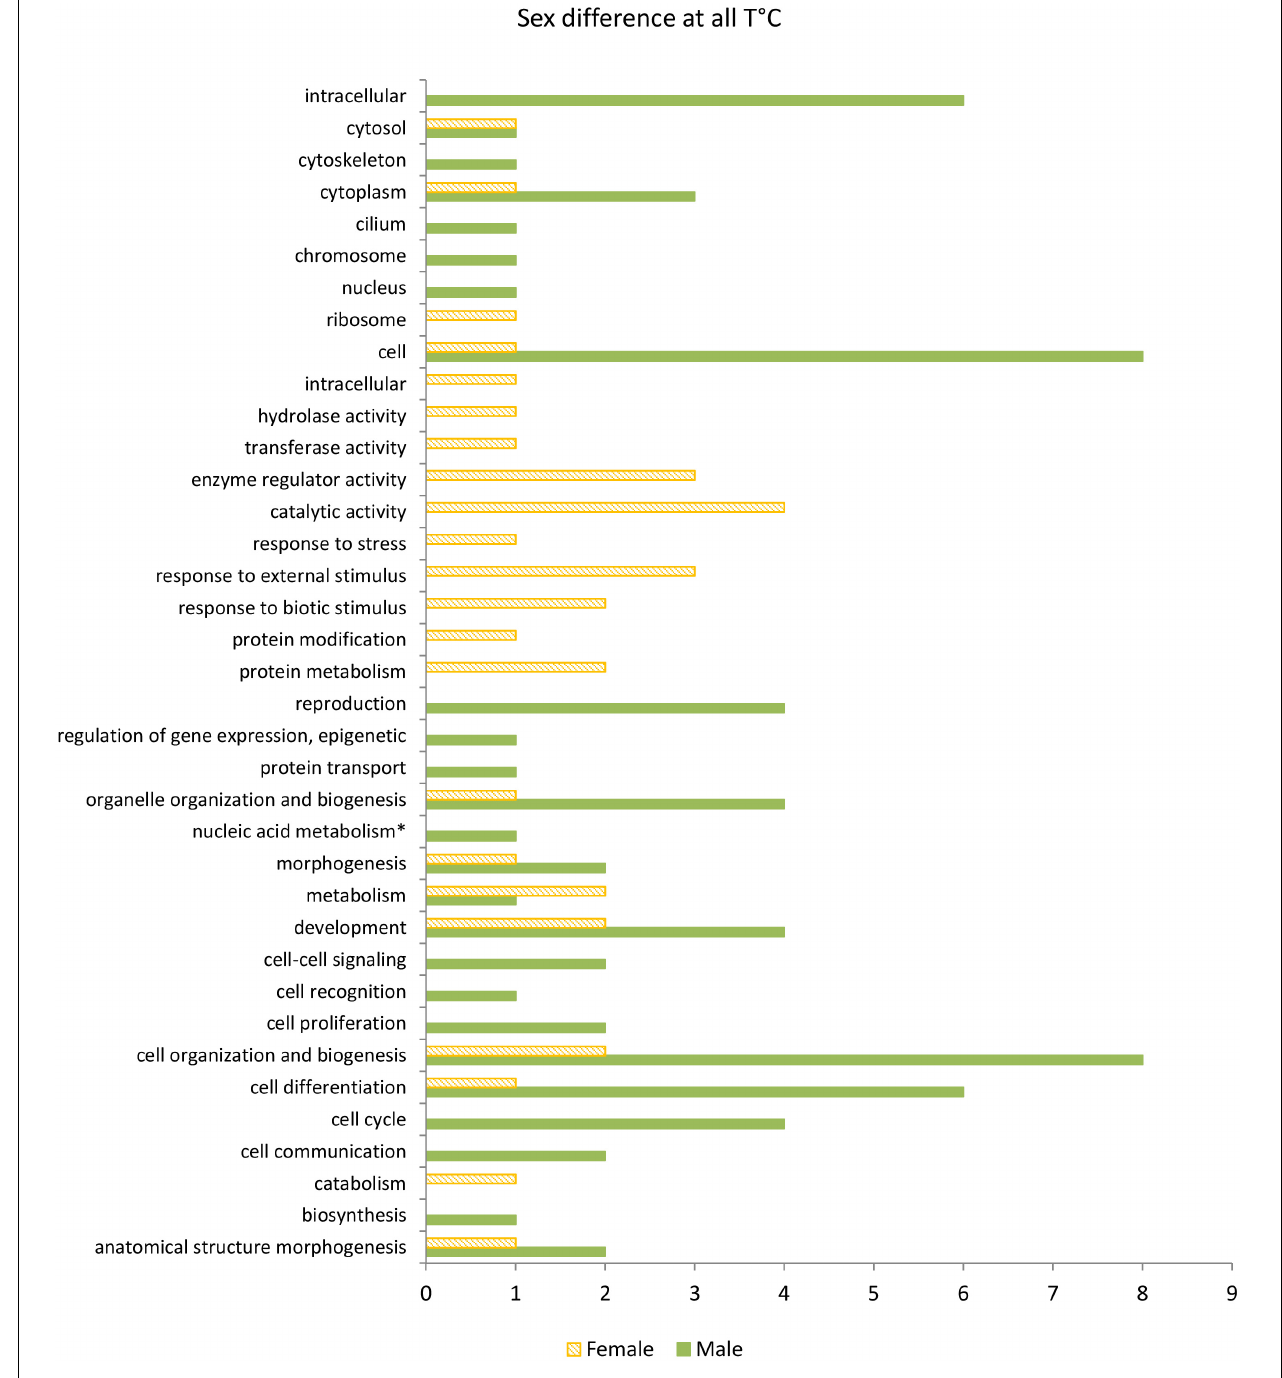
FIGURE 4 | Over-represented GO terms of DEGs consistently up-regulated in female (orange in diagonal stripes) and male (green) gametophytes of Saccharina latissima across all temperatures, according to the categories of GO slim (GOseq, p < 0.05, n = 3). Nucleic acid metabolism ∗ stands for nucleobase, nucleoside, nucleotide, and nucleic acid